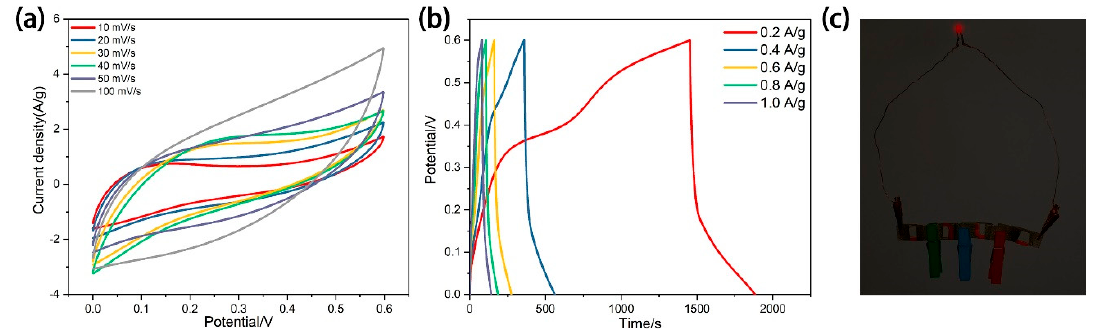
Figure 4. ( a ) The CV curves of screen printed SCs device at 10–100 mV s − 1 , ( b ) the GCD curves of screen printed SCs device at 0.2–1.0 A g − 1 , ( c ) image of four screen-printed SCs connected end to end lighting up a red LED.